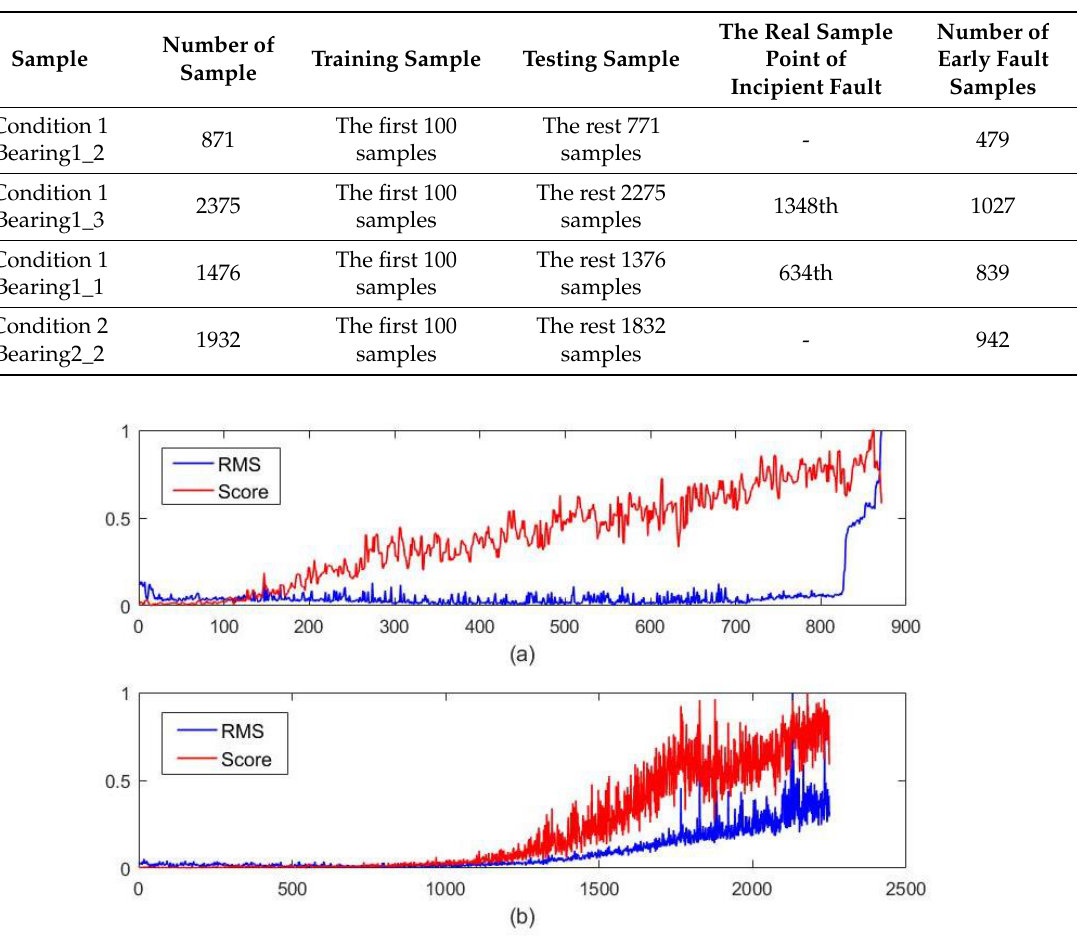
Figure 5. The comparison results of abnormal score and the RMS value with ( a ) XJTU1_1 and ( b ) XJTU 2_2. 4.4. Comparative Results To verify the superiority of the proposed algorithm, comparison between five other widely used methods for incipient fault diagnosis and detection and the proposed method is made. Among them, bandwidth empirical mode decomposition and adaptive multiscale morphological analysis (BEMD-AMMA) [35] is a typical method based on weak signal analysis, local outlier factor (LOF) and isolation forest (iFOREST) are two